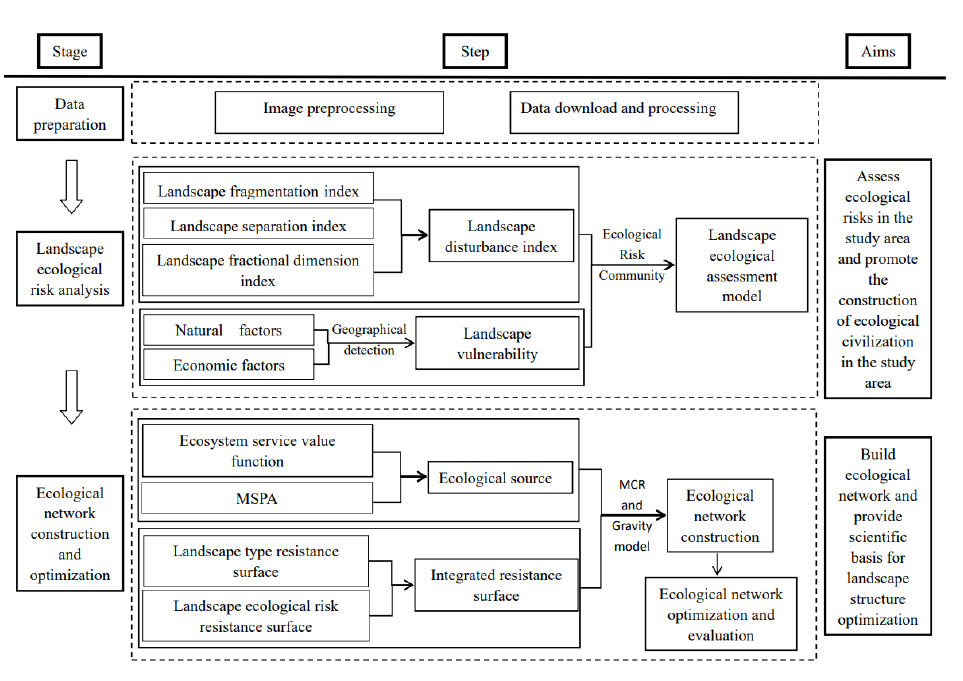
Figure 3. Flow diagram of ecological network construction and optimization.